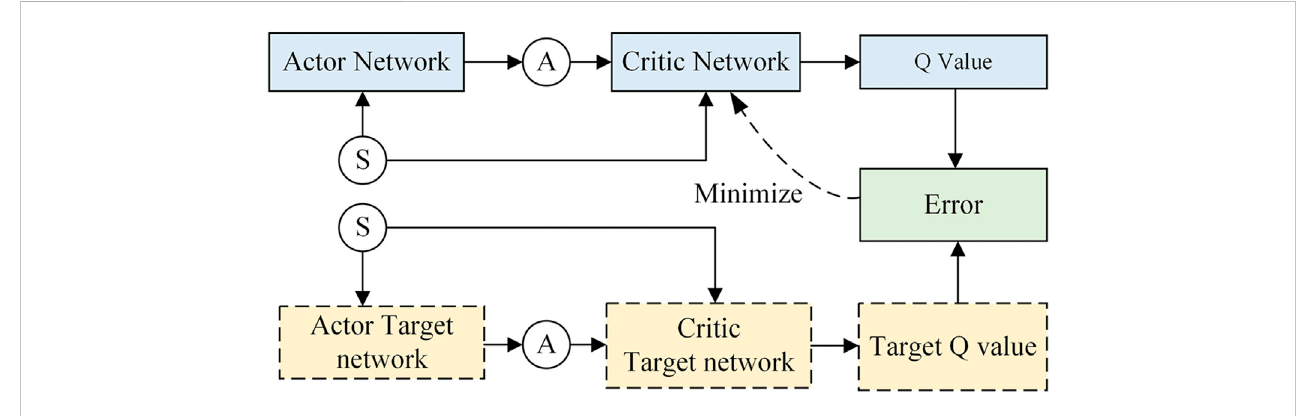
FIGURE 6 Diagram of the relationship between the actor and critic